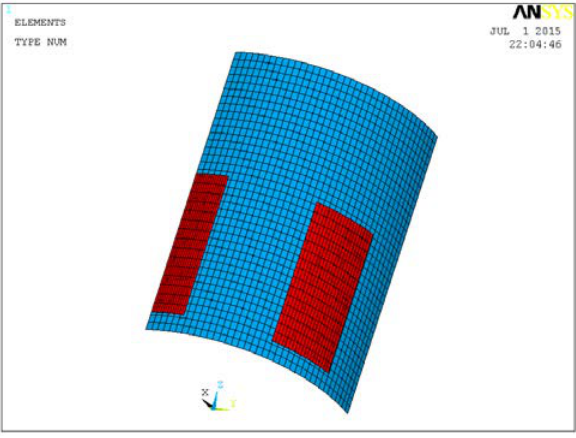
Figure 4: Contact cells between horizontal oriented slider and external